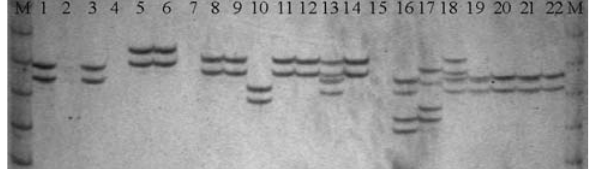
Figure1 -Silverstained4%(w/v)acrylamidegelshowingpolymorphism at locus Ah282 in plants of Arachis schinini (plants 1 to 3), Arachis hoehnei (plants4to8)and Arachishelodes (plants9to22).Thenumberof fragments in the plants ranged from two (plants 1, 3, 5, 6, 8, 9, 11, 12, 14, 19, 20, 21, 22) to four (plants 13, 16, 17, 18). It can also be seen that some plants (17 and 19) from the same species did not share any fragment with each other. M = molecular weight.